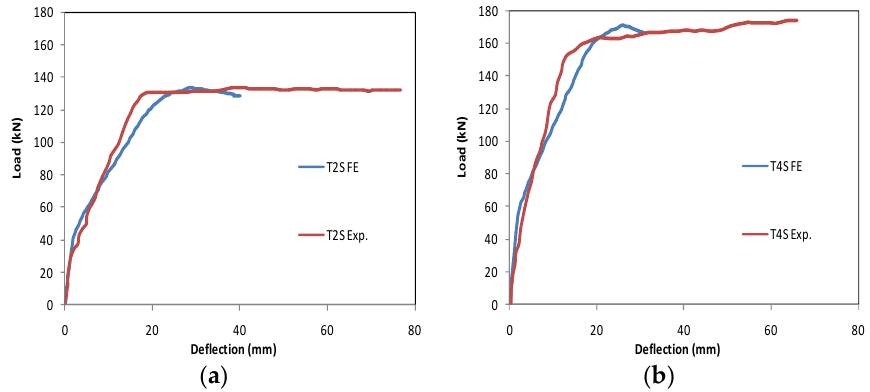
Figure 10. Load–displacement relation for laboratory tests (Adapted from Ref. [26]). versus FE tests: ( a ) Beam T2S; ( b ) Beam T4S.